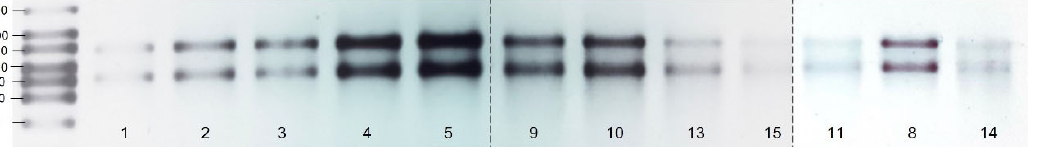
Figure 3. Image of gel electrophoresis of RNA samples from intracellular S. aureus 90 min, 24 h, and 48 h postinfection (condition II) from five independent experiments. The 16 S and 23 S (bacterial) rRNA bands are visible. Numbers refer to Table 2’s samples. RNA ladder in bp. The amount detected on gel does not correspond with the amount measured via Nanodrop.